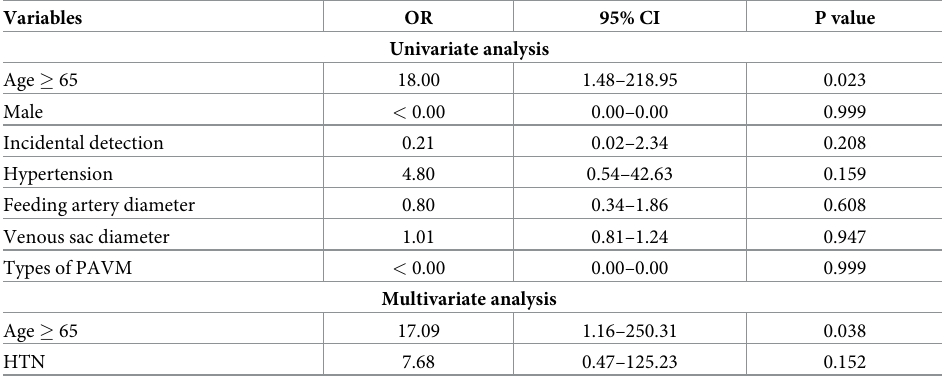
Table 3. Risk factors for new cerebral complications in untreated patients after PAVMs were detected (n =